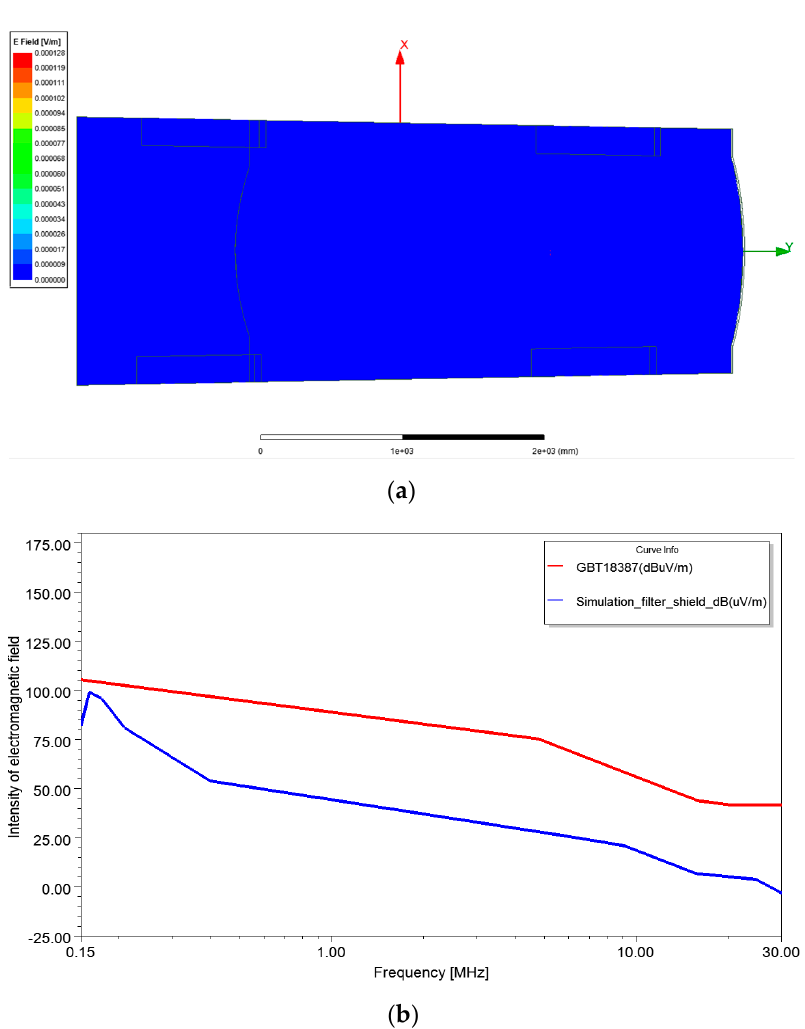
Figure 11. ( a ) Distribution of electromagnetic field; ( b ) electric field intensity at 3 m.